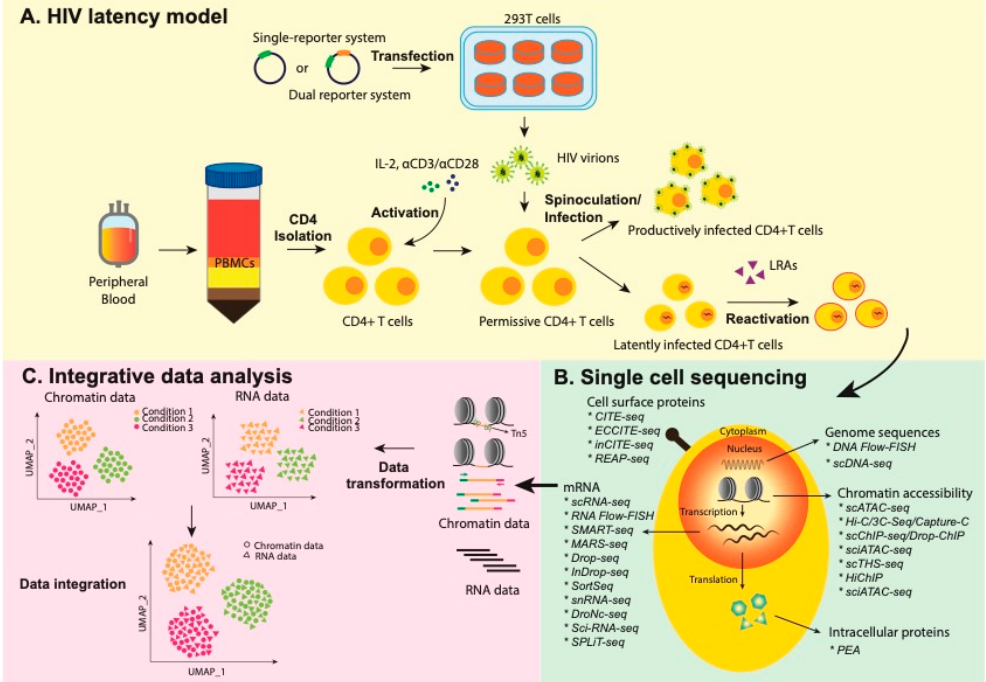
Figure 1. Schematic of integrative analysis of HIV-1 latency. ( A ) Establishment of HIV-1 latency in model systems that use primary human CD4 + T lymphocytes. Generally, cells are activated, infected by reporter HIV-1 constructs, and allowed for returning to a quiescent state prior to reactivation with pharmacologic latency reversal agents (LRA). ( B ) Summary of single-cell technologies to characterize transcriptome, proteome, and regulome. ( C ) Integration approaches to single-cell datasets that assess transcription and chromatin accessibility. Tn5 transposases, coupled with DNA adapters, fragment and tag accessible genomic DNA. Resulting fragments are amplified and sequenced to generate chromatin accessibility